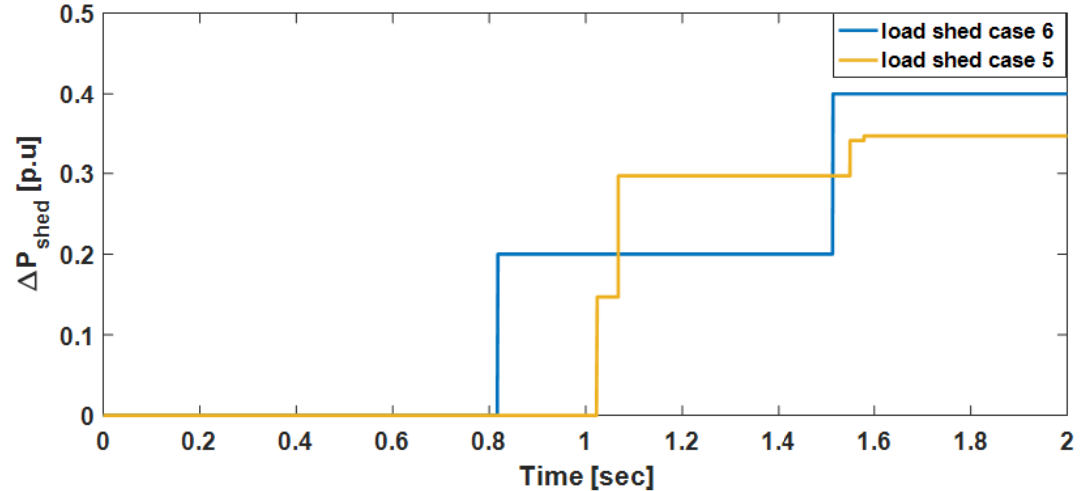
Figure 10. The amount of load to be shed in third scenario: a comparison between cases 5 & 6.